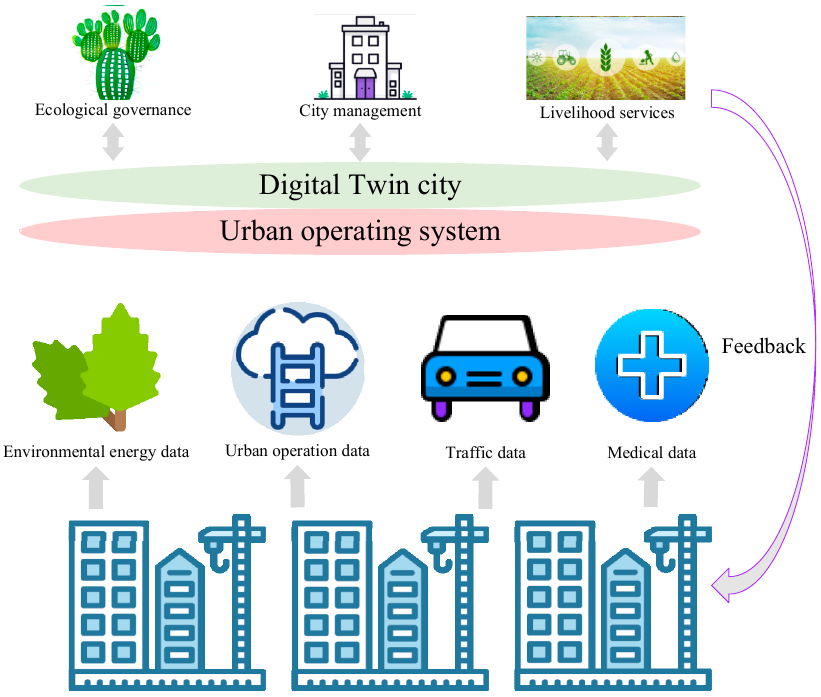
Figure 4. The main function of a DT city (Source: the authors).